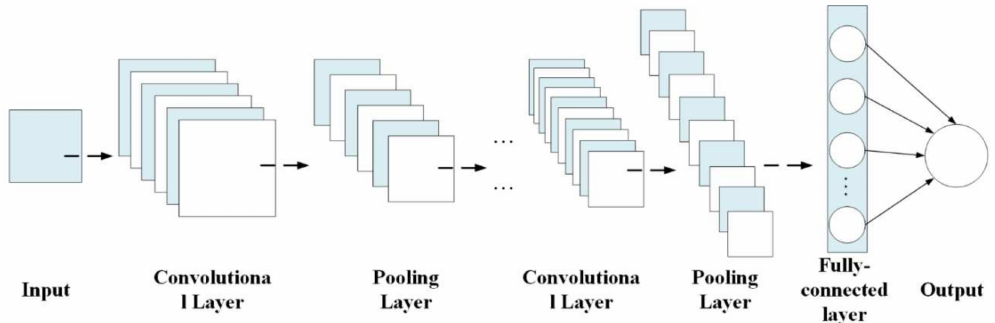
Figure 6. The basic structure of the CNN algorithm.